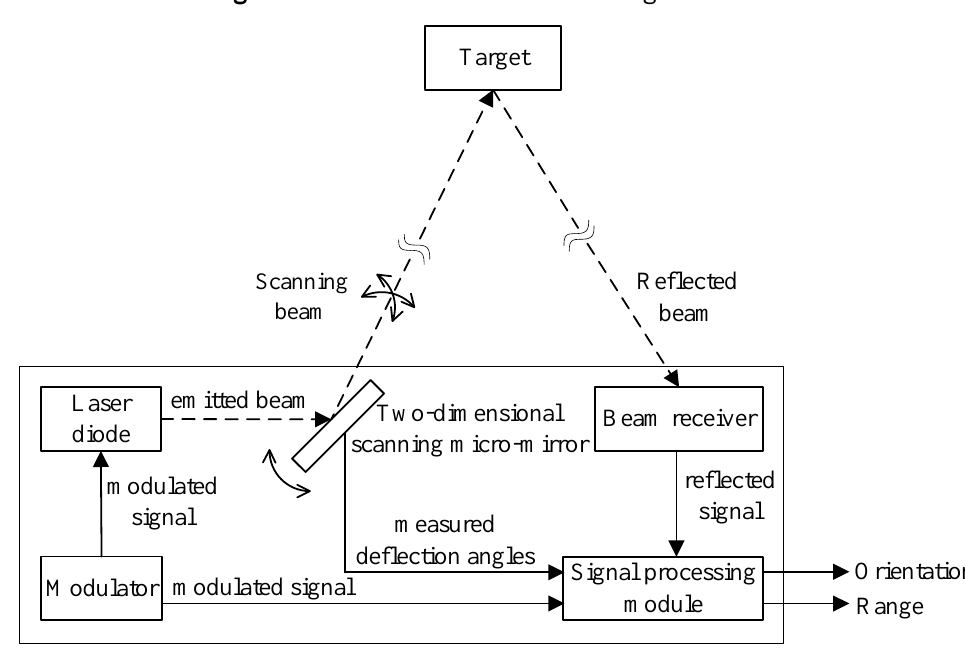
Figure 11. Structure of MOEMS target detector.